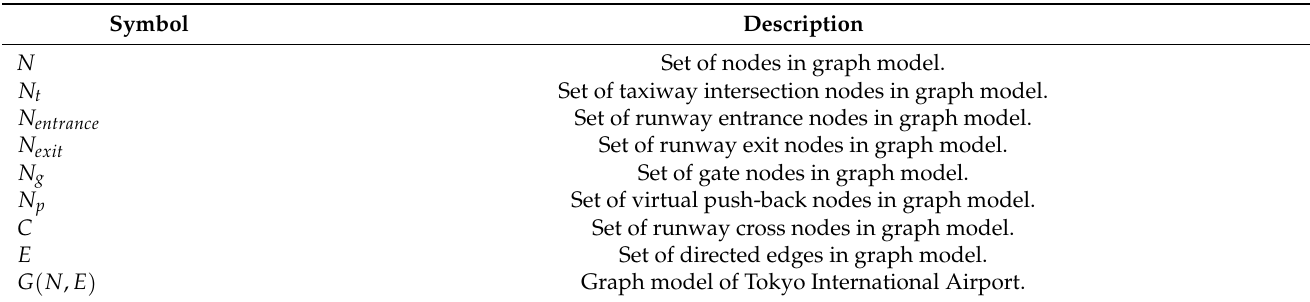
Table 1. Definition of mathematical notation in Section 3.